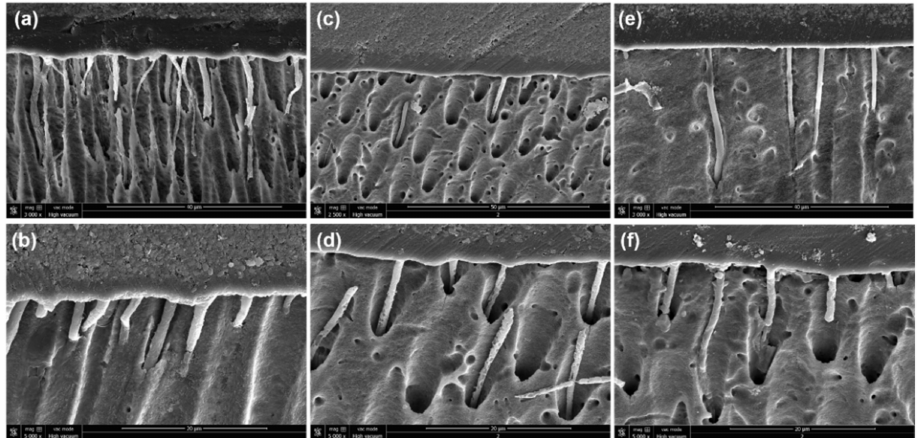
Figure 6. Representative scanning electron microscopy micrographs ( × 2000 and × 5000 magnifica- tions) demonstrating the adhesive layer thickness: ( a , b ) adhesive group (control), ( c , d ) adhesive + 0.5% PY, and ( e , f ) adhesive + 1%